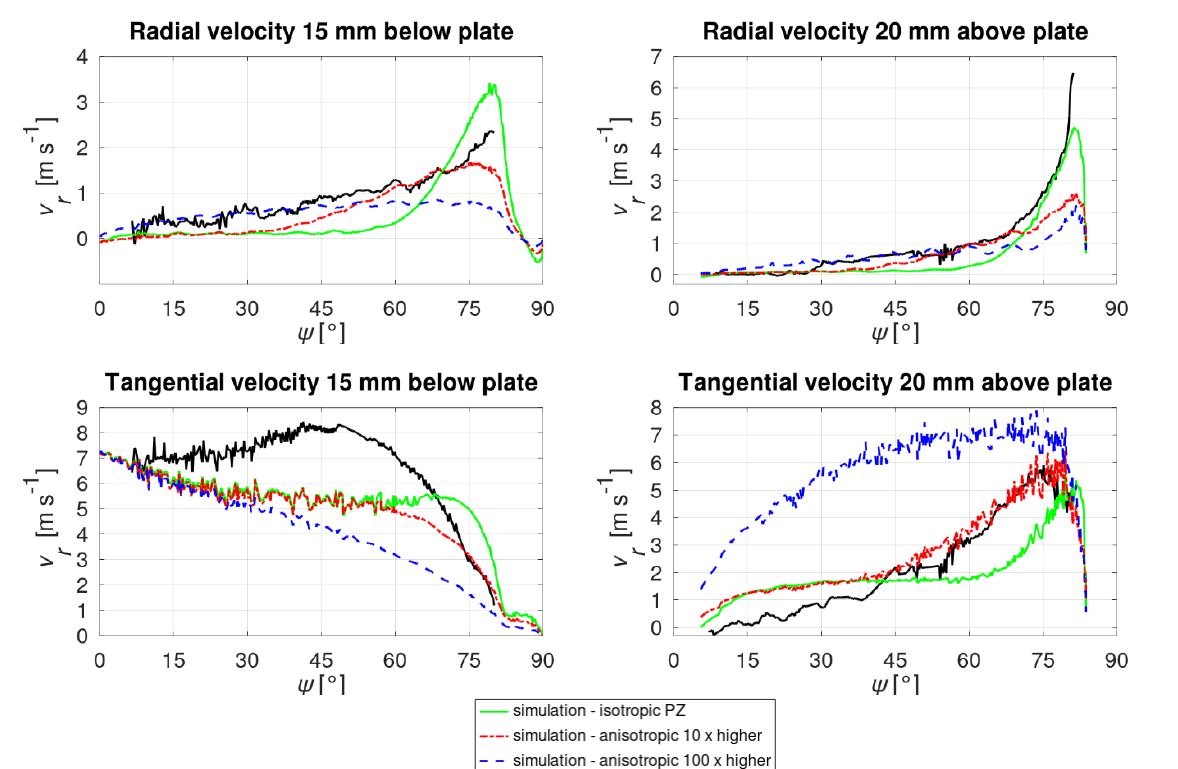
Fig. . Radial and tangential velocity for mean velocity 7m/s and empirical method porous zone coefficients .